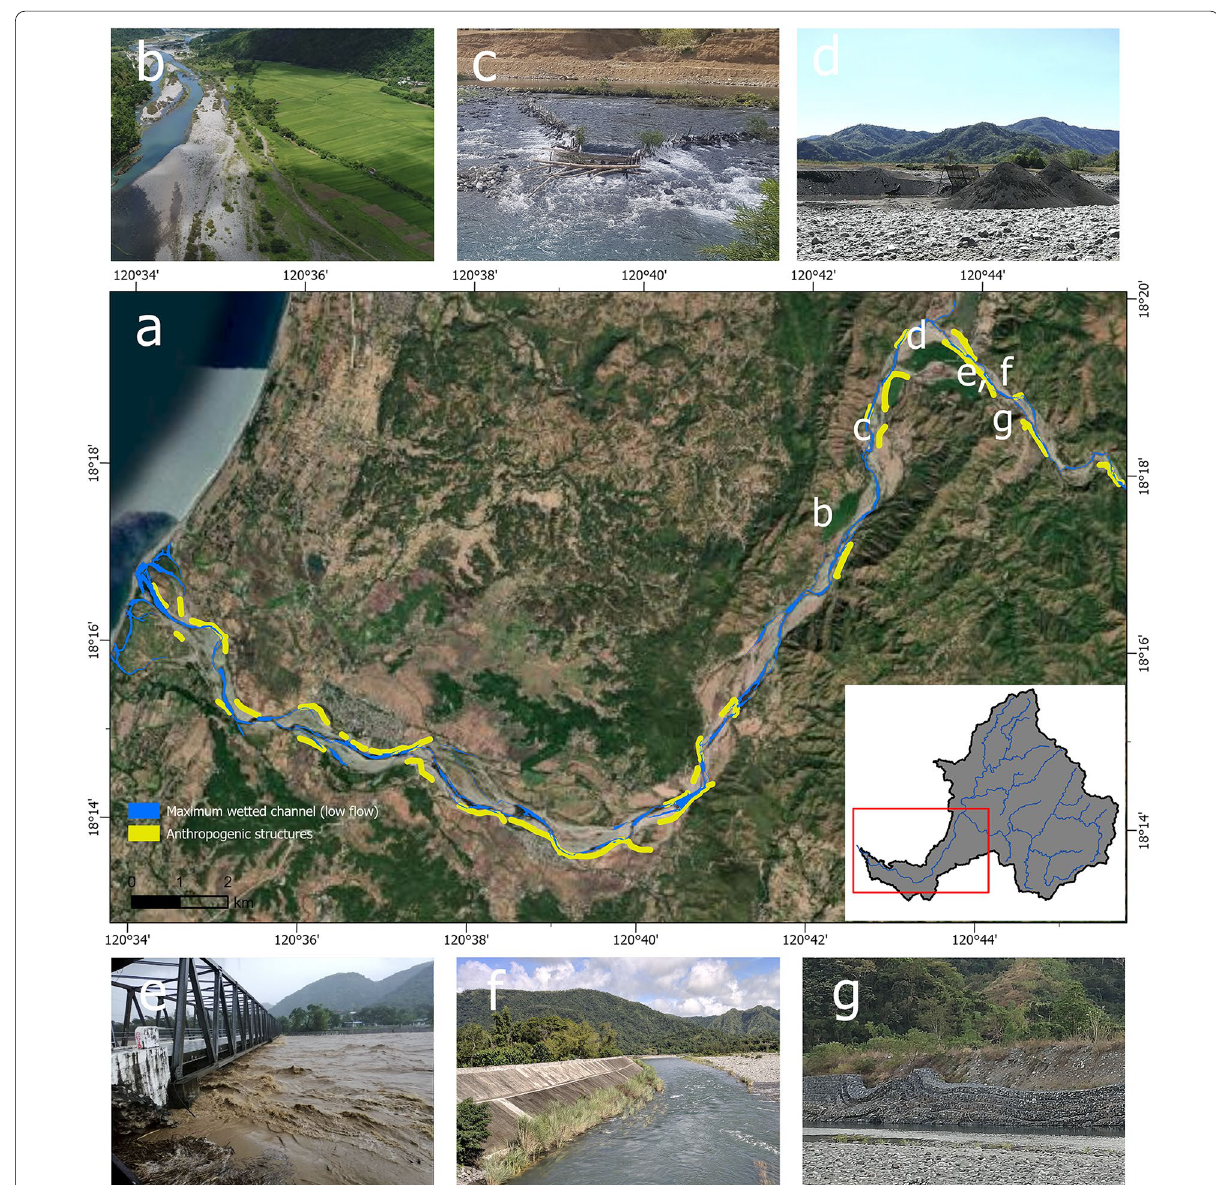
Fig. 1 a The Bislak River, like many rivers in the country, serves multiple purposes in Philippine communities, including: b agriculture on floodplains; c aquaculture/fish pens in channels; and, d the provision of construction materials from gravel mining on riverbeds and bars. Semi-permanent/ permanent structures such as bridges, embankments, dikes, and gabions ( e – g ) are commonly constructed along Philippine rivers. Examples shown are from the Bislak Catchment; locations are indicated by the corresponding labels ( a – g